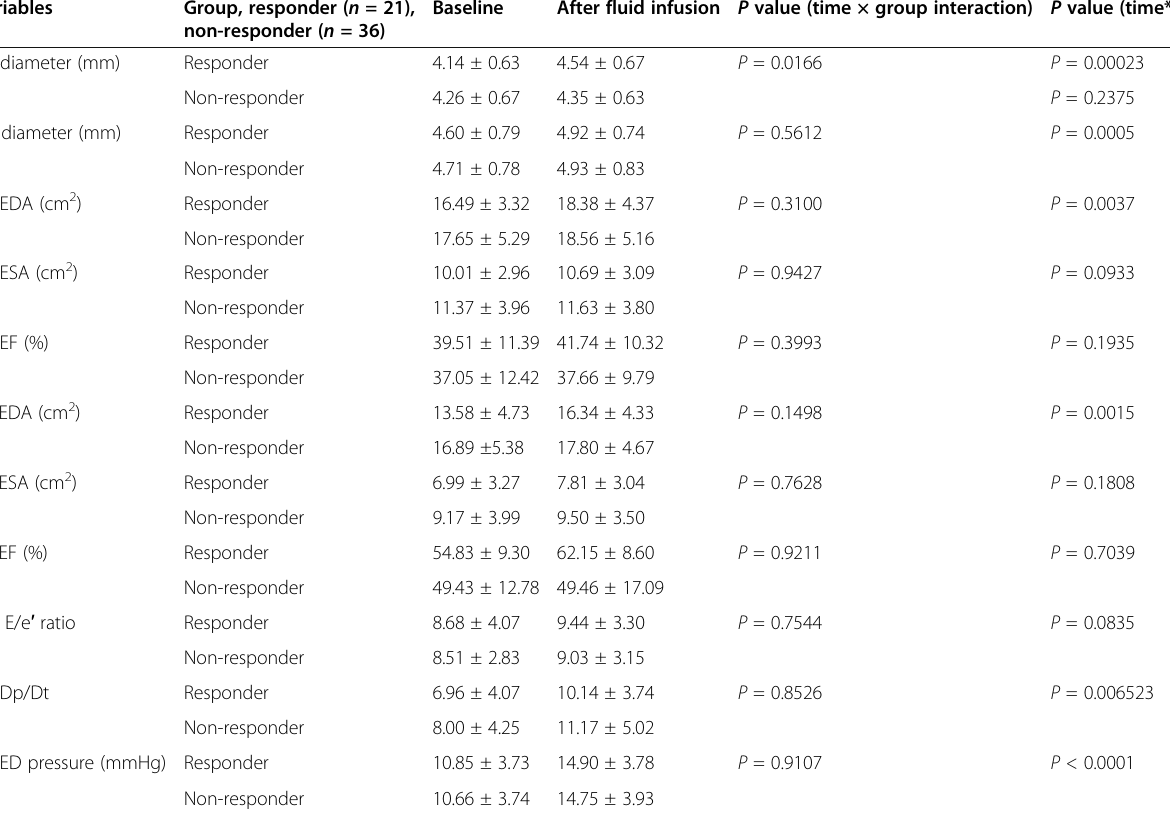
Table 5 Echocardiographic parameters, RV dp/dt, and end diastolic RV pressure before and after fluid infusion